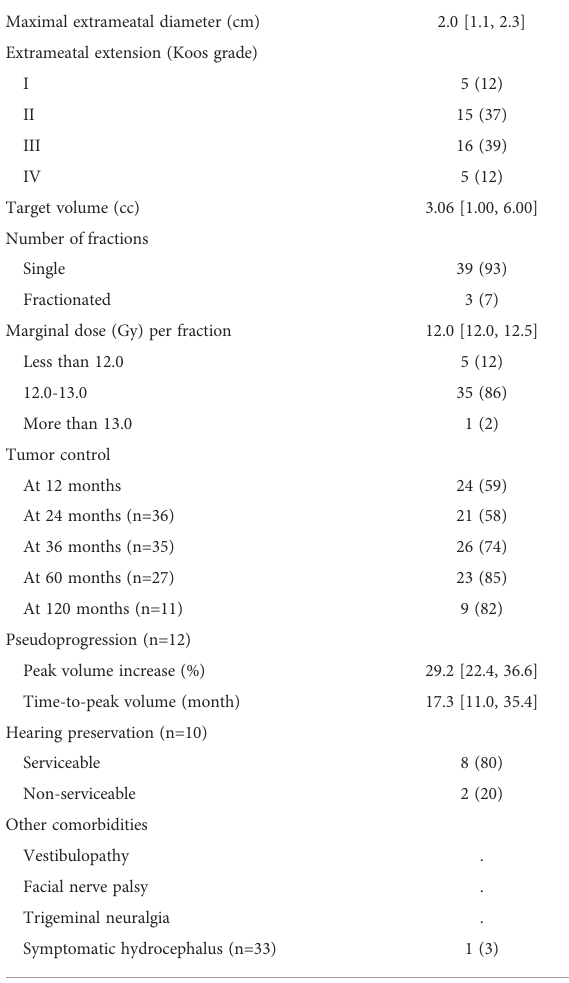
TABLE 2 Treatment factors and